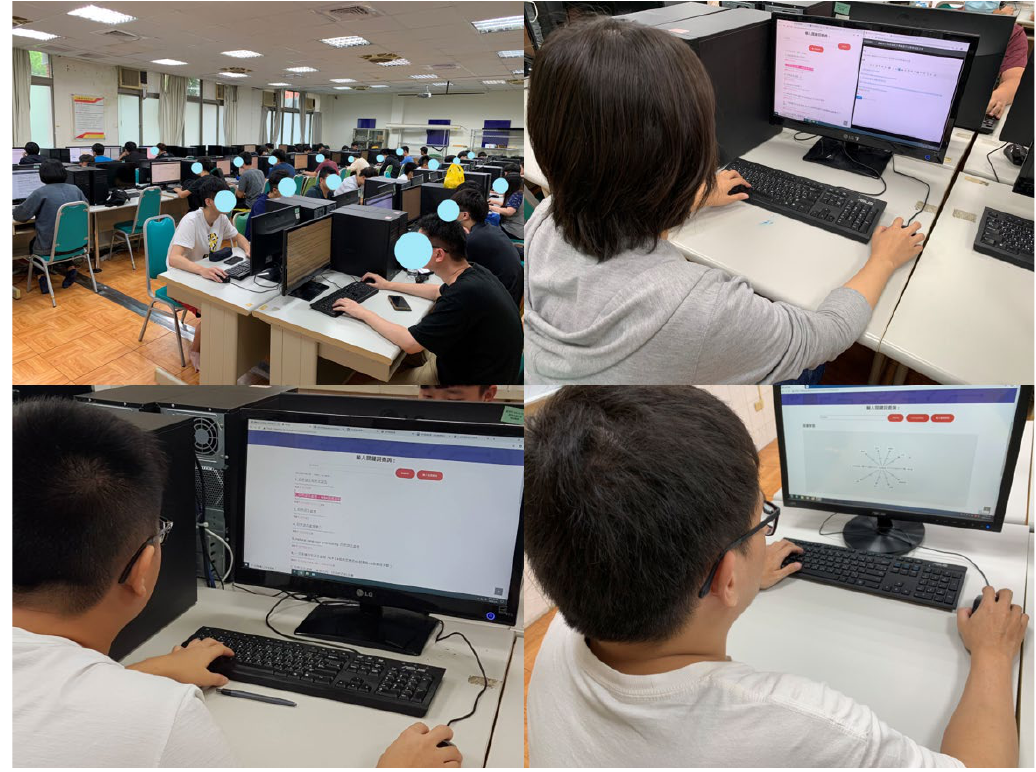
Learning Conditions for the Experimental